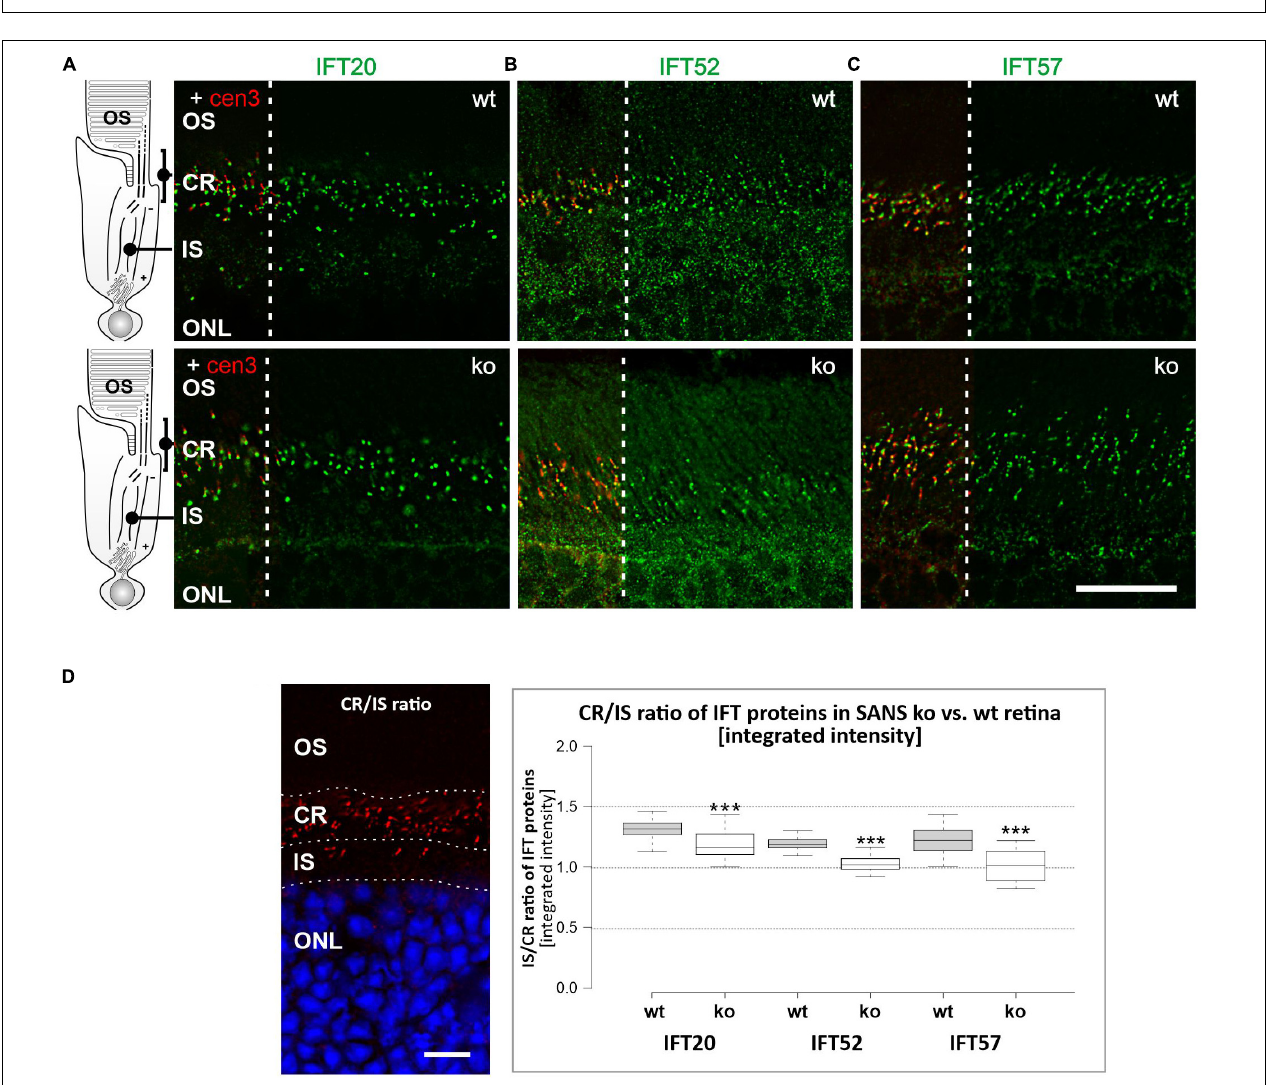
FIGURE 4 | Subcellular localization of SANS and IFT-B proteins in the ciliary region of murine photoreceptor cells. (A) Indirect immunofluorescence triple labeling of SANS and with IFT20, IFT52, and IFT57 of photoreceptor layers in longitudinal cryosections of murine wild type retinas co-stained with anti-centrin3 (cen3), a marker for the connecting cilium (cc), basal body (bb) (mother centriole), and the adjacent (daughter) centriole (ce) of photoreceptor cells. CR, ciliary region; OS, photosensitive outer segments; the IS, inner segment; MT, microtubule tracks through the IS. (B) High magnification of photoreceptor cilia from areas indicated by rectangles in (A) . (C) Intensity plots of the immunofluorescence of the photoreceptor cilia shown in (B) . (D) Measurements of the Manders’ Colocalization Coefficients (MCC) of subciliary compartments of photoreceptor cilia, namely the cc (highlighted by green circle) and ce. Numbers from 0 to 1 indicate increasing co-localization of molecules M1 (SANS) and M2 (IFT). (E) Schematic illustration of the localization of SANS (green), IFT20 (red), IFT52 (yellow), and IFT57 (purple) in photoreceptor cilia. Partial co-localization of SANS with the IFT-B molecules at the ciliary base is indicated by orange color. # indicates OS base where disk neogenesis takes place. Ax, axoneme. Scale bar: 10 µ m (A) ; 1 µ m (B) .